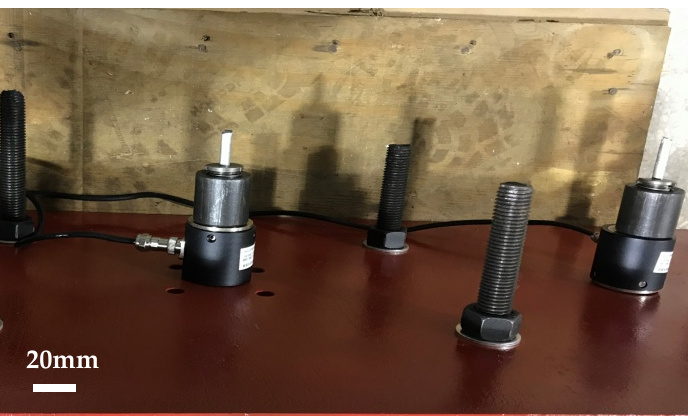
Figure 6. Hollow shaft type annular force sensor.